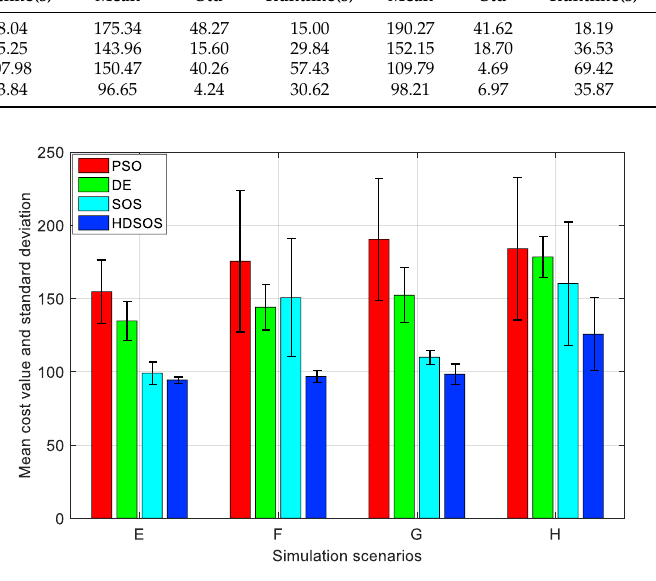
Figure 14. Performance comparison of algorithms among